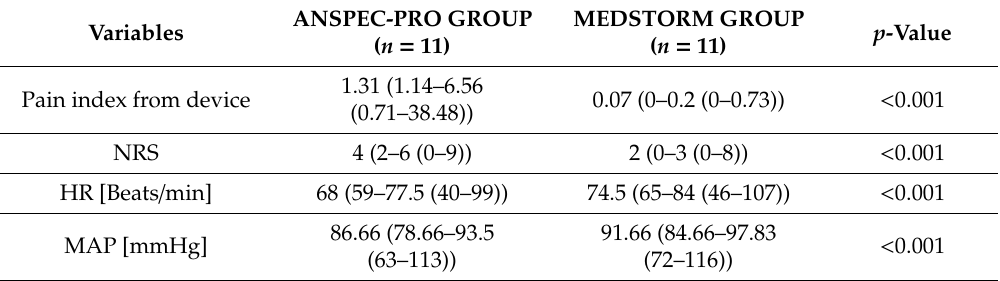
Table 2. Postoperative outcome parameters in post-anesthesia care unit (PACU).